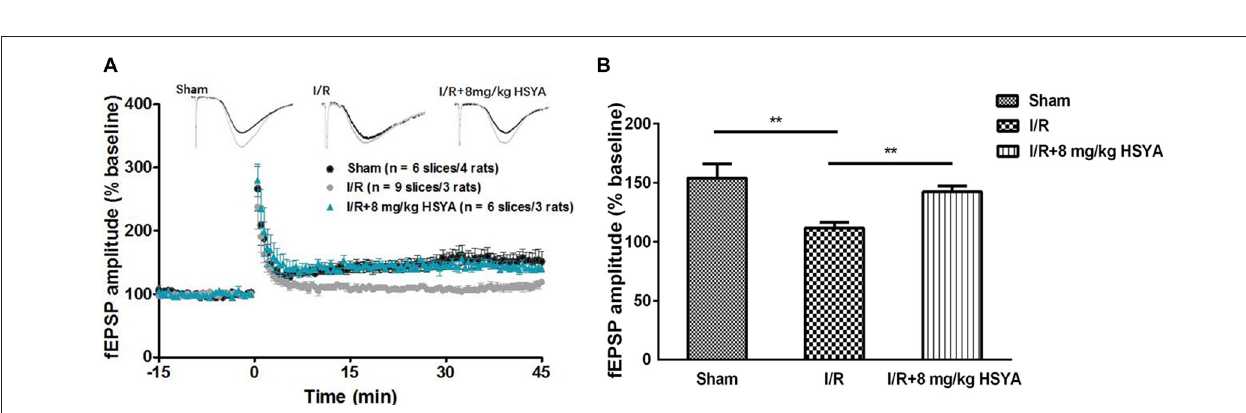
FIGURE 6 | Neuroprotective effects of HSYA on recovery of long-term potentiation (LTP) in MCAO rats. (A) Values are expressed as percentage of change relative to baseline. (B) The average percent change of field excitatory post-synaptic potential (fEPSP) amplitude 45 min after theta burst stimulation (TBS). The values are shown as means ± SEM. ∗∗ Represent significant differences before and after tetanic stimulation for sham, MCAO and 8 mg/kg HSYA groups, respectively ( ∗∗ P <